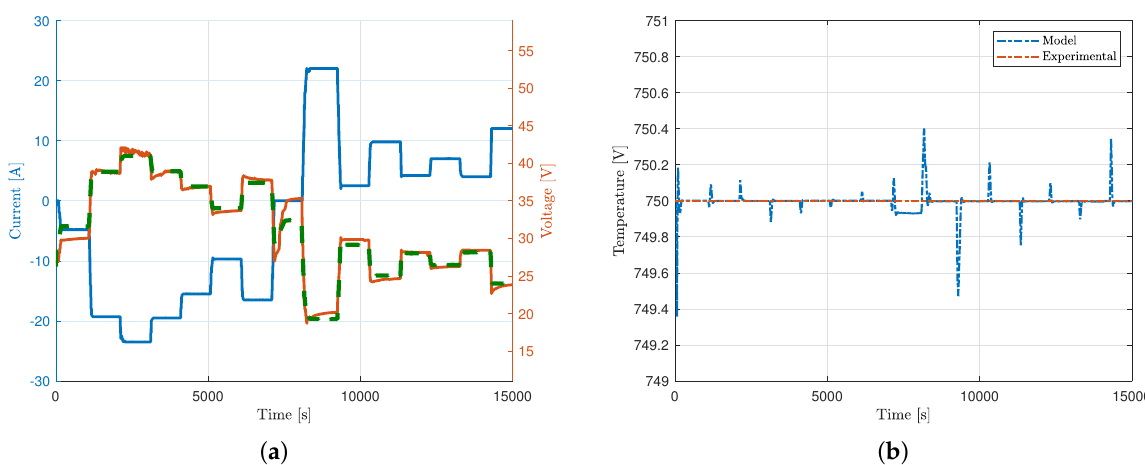
Figure 4. Dynamic response. ( a ) Superposition of model (green) and experimental (orange) responses. Current in blue, the experimental voltage in orange and the model response in green. ( b ) Stack furnace temperature